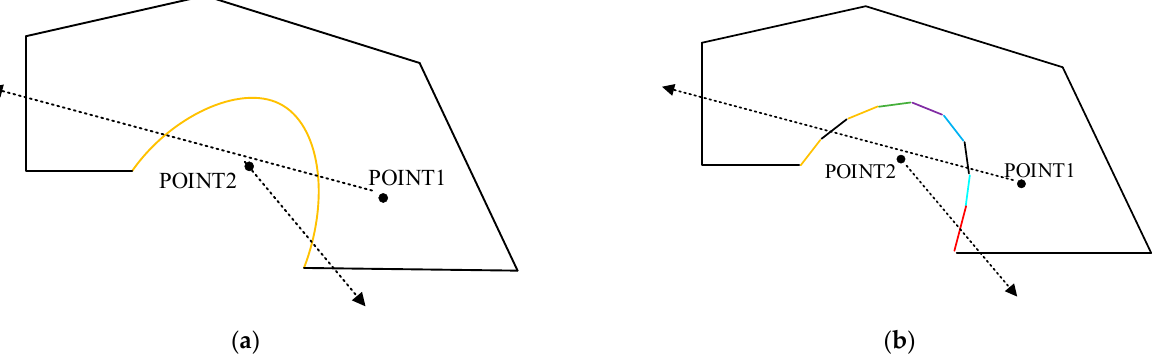
Figure 6. The illustration of the ray casing method. ( a ) A polygon includes a curve; ( b ) A curve is reduced to a polygon with multiple straight lines.